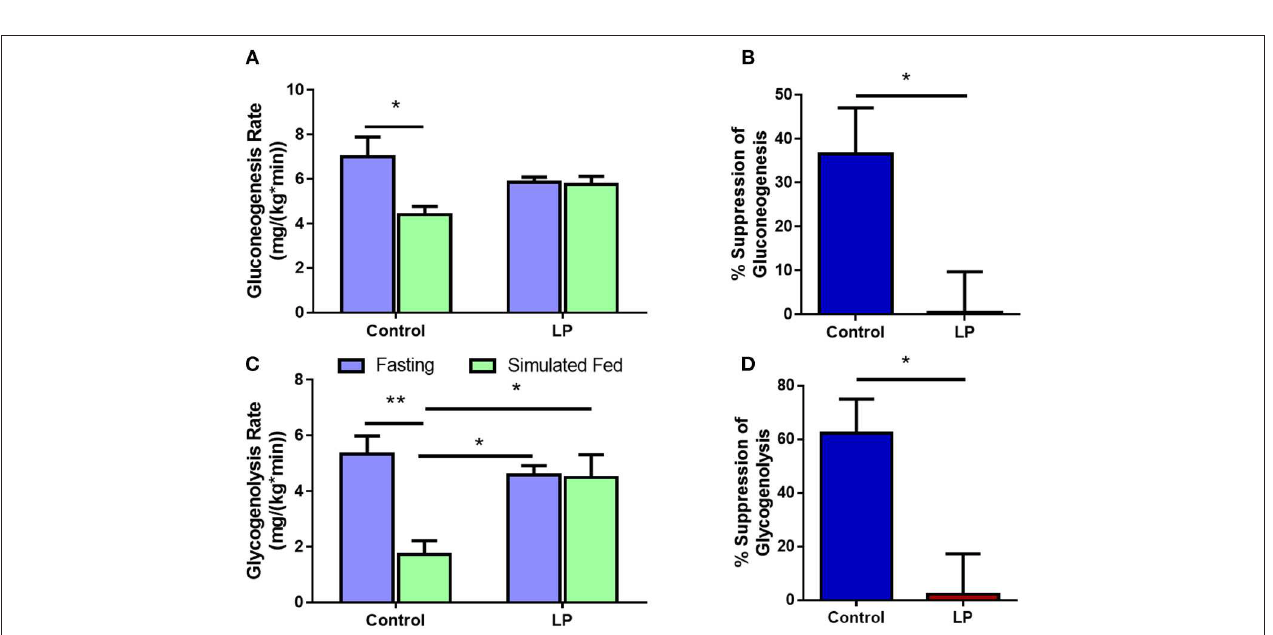
( p < 0.01) during glucose infusion ( Figures 5A,B ). In T2D group, the rate of glucose production by GNG was 5.8 ±